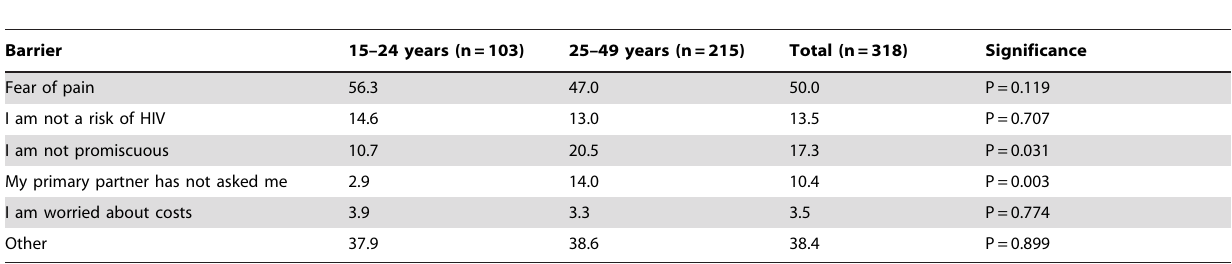
Table 5. Barriers to VMMC by age among males aged 15–49 not willing to be circumcised.